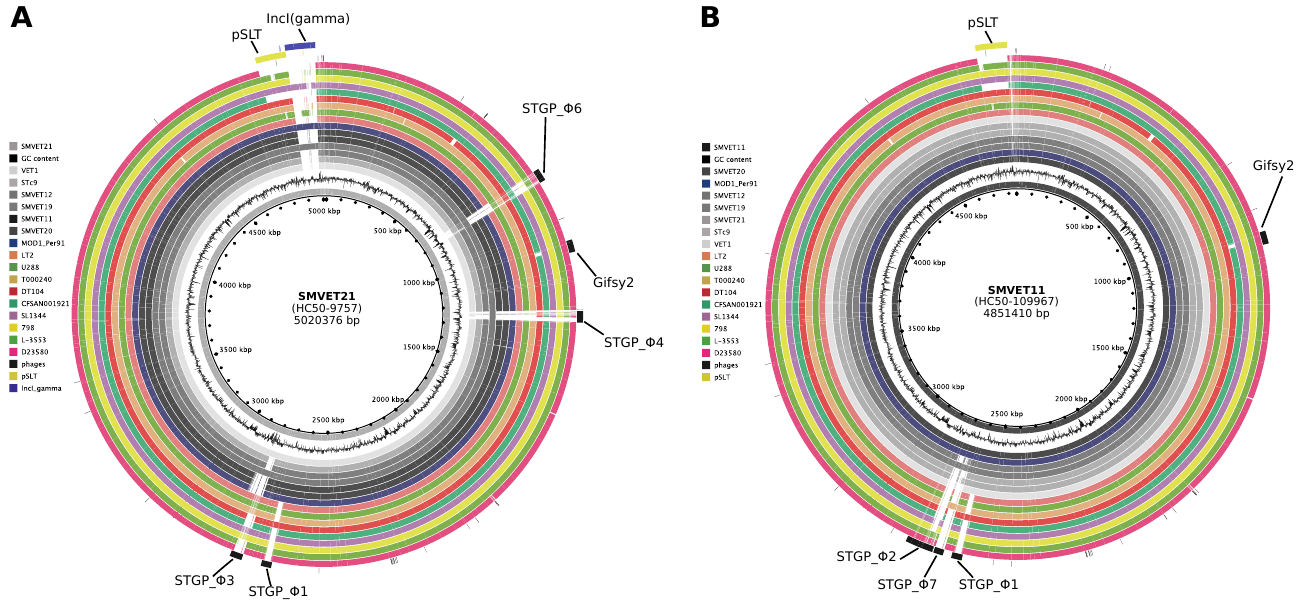
Figure 3. Comparative genomic showing differential prophage profiles in guinea pig isolates. Each ring represents the genome of a single S. Typhimurium isolated mapped to the ( A ) SMVET11 strain (H50-9757) or ( B ) SMVET11 strain (H50-109967); from the inner to the outermost ring, the first (innermost) ring shows the genome size in kbp, followed by SMVET21 ( A ) or SMVET11 ( B ), GC content (black), 6 guinea pig genomes (gray scale), and complete reference genomes from different host and location (colors). The predicted phage regions (black), pSLT (yellow), and IncI γ (gamma) (blue) plasmids are in the outermost